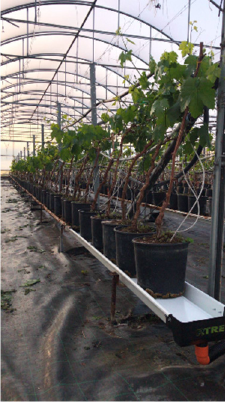
Figure 2. Table-grape soil-less cultivation in pots under greenhouse tunnels designed for recovery of drainage irrigation water (semi-closed cycle system). drainage irrigation water (semi-closed cycle